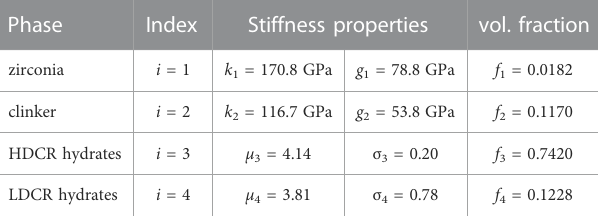
TABLE 8 Input quantities of the solid material constituents: bulk moduli, k i , shear moduli g i , as well as lognormal parameters μ i and σ i which are consistent with median and mode values listed in Table 7; input values taken from (Hussey and Wilson, 1998), (Pichler and Hellmich, 2011), and (Dohnalík et al.,